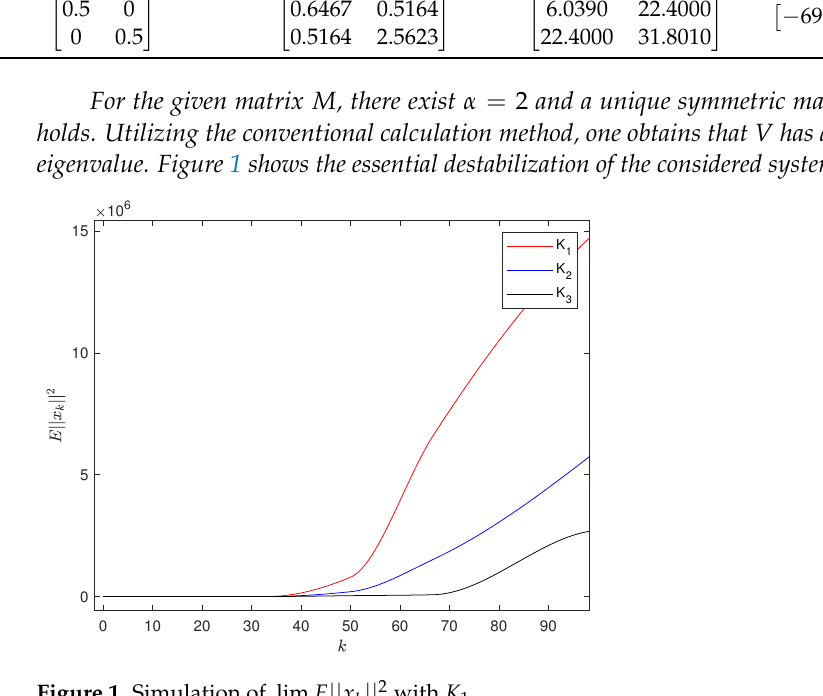
Figure 1. Simulation of lim